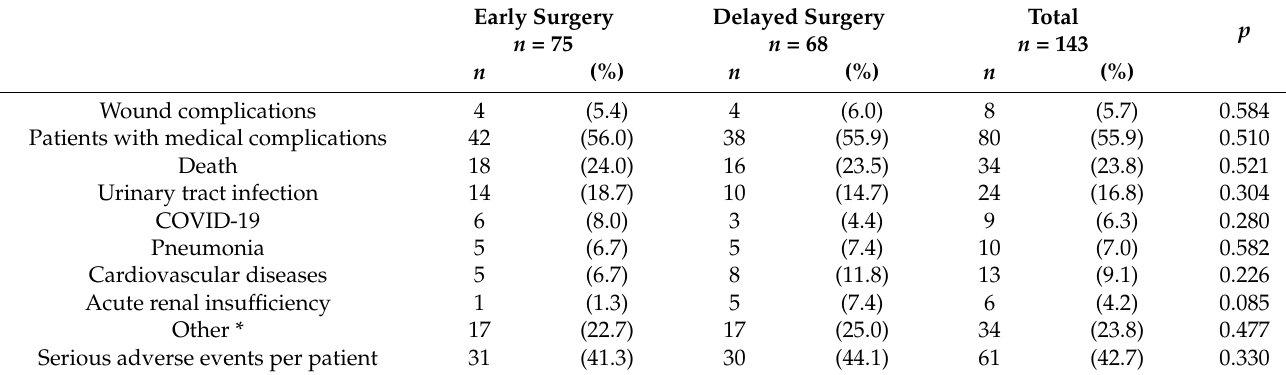
Table 2. Medical and surgical complications after hospital discharge per patient.